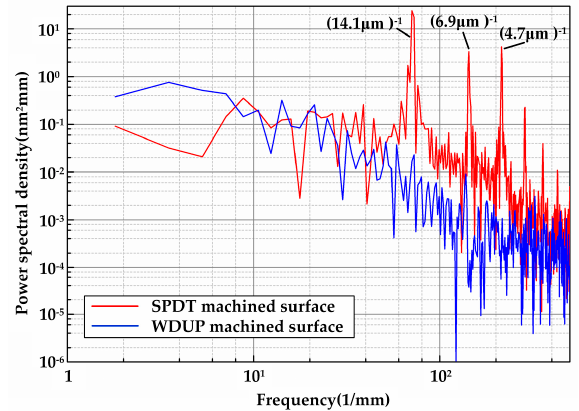
Figure 4. 1D-PSD comparison of Single Point Diamond Turning (SPDT) and water dissolution ultra-precision polishing (WDUP) machined crystal surface.